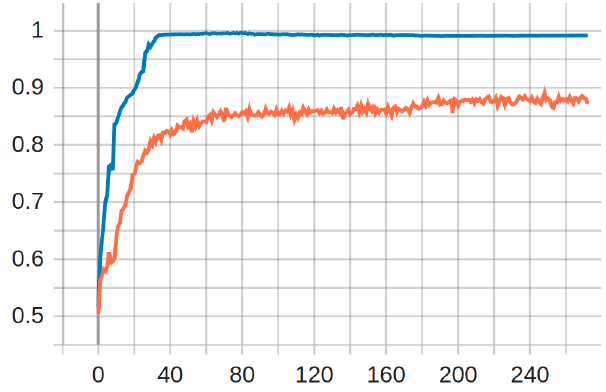
Figure 7. ROC AUC over epochs. Orange color indicates training and blue indicates validation.